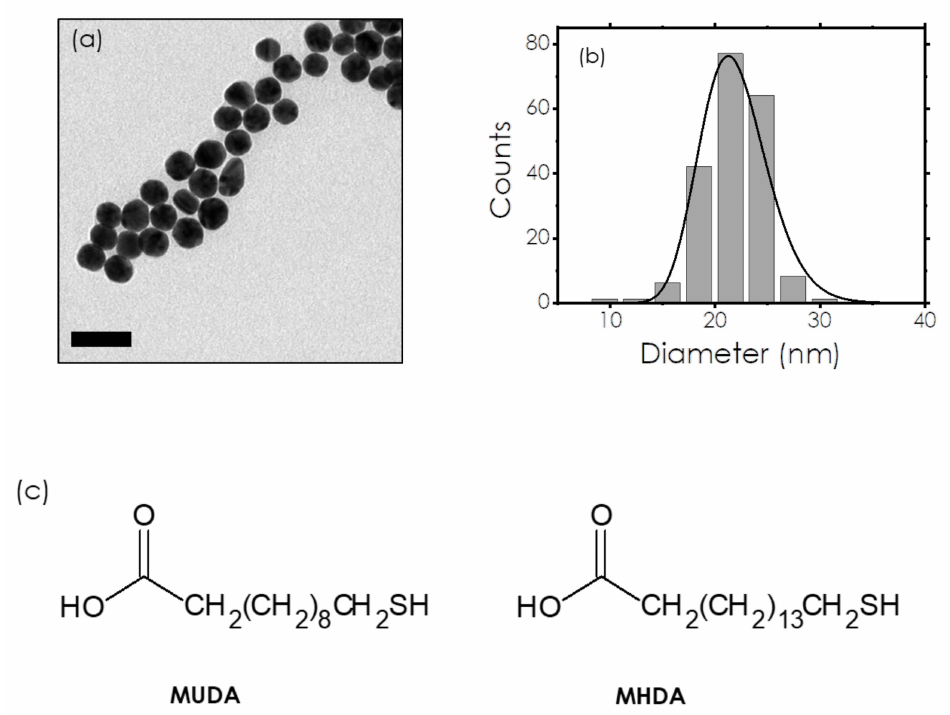
Figure 1. ( a ) Transmission Electronic Microscope (TEM) picture of nanoparticles stabilized with citrate prior to any thiol functionalization (scale bar 50 nm). ( b ) Size distribution of the nanoparticles and log- normal fit showing an average size of 21.7 ( σ = 0.15). ( c ) Chemical structures and abbreviation of the alkanethiols used in this study: 11-mercaptoundecanoic acid (MUDA) and 16-mercaptohexadecanoic acid